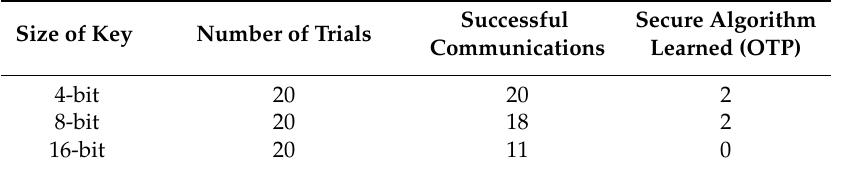
Table 2. 20 networks were learned with ANC and tested using Algorithm 1 for each key size. Not all trials were successful since Alice and Bob were not able to communicate without errors in some cases. The network learned a secure algorithm (OTP) in some rare